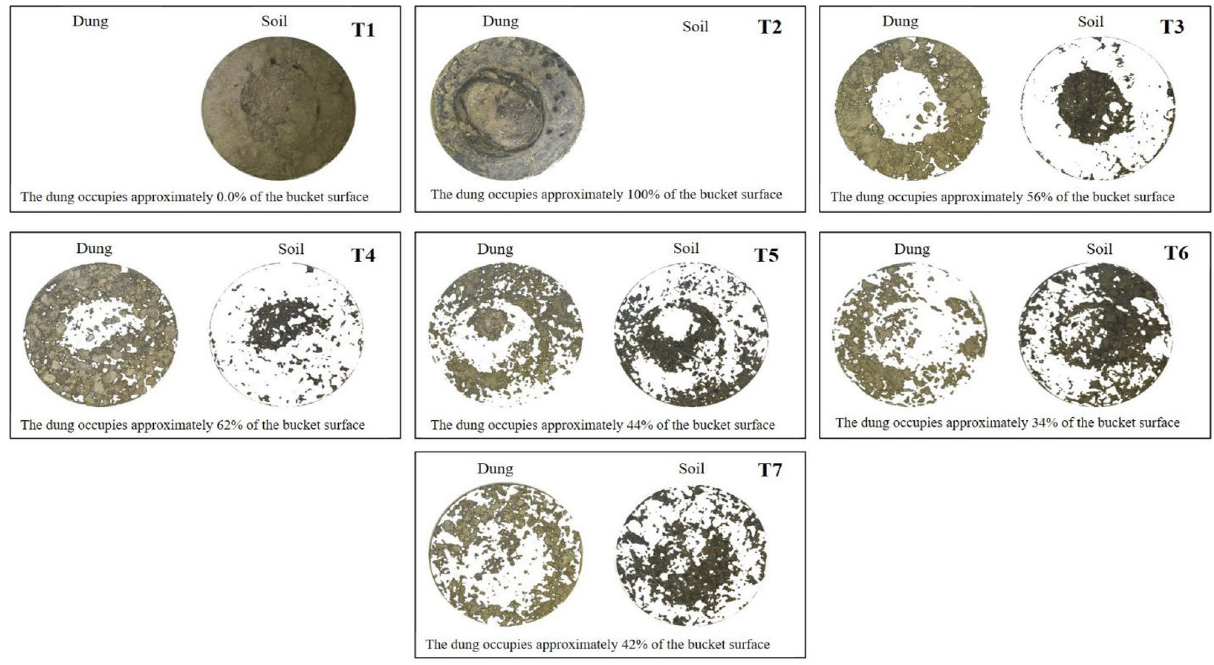
Figure 3. Dung removal of single dung beetle species and their combinations. T1: just soil, T2: soil + dung, T3: soil + dung + O. taurus (OT), T4: soil + dung + D. gazella (DG), T5: soil + dung + P. vindex (PV), T6: soil + dung + OT + DG, T7: soil + dung + OT + DG +